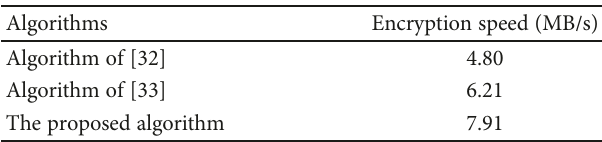
Figure 23: Wrong decryption result. Table 1: Comparison of encryption speed between di ff erent